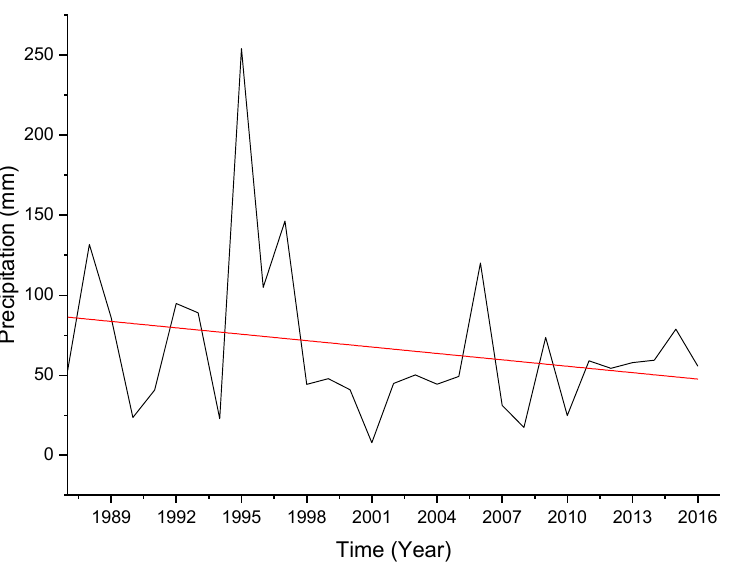
Mean temperature and total monthly rainfall data from six weather stations were divided into seasonal subsets; for example, winter (December, January, February = DJF), summer (June, July, August = JJA), spring (March, April, May = MAM) and autumn (Sep- tember, October, November = SON) seasons. Seasonal data analysis demonstrated that mean monthly temperature during DJF ( τ = 0.173, S = 0.016, p < 0.01), MAM ( τ = 0.358, S = 0.02 (Sen’s slope), p < 0.0001), JJA ( τ = 0.362, S = 0.011, p < 0.0001), and SON ( τ = 0.335, S = 0.014, p < 0.0001), has increased significantly ( p < 0.05) over the 30 year period of observa- tion. As indicated by the Mann Kendall tau value, increasing trends are comparatively prominent during summer, spring and autumn (Figure 4).